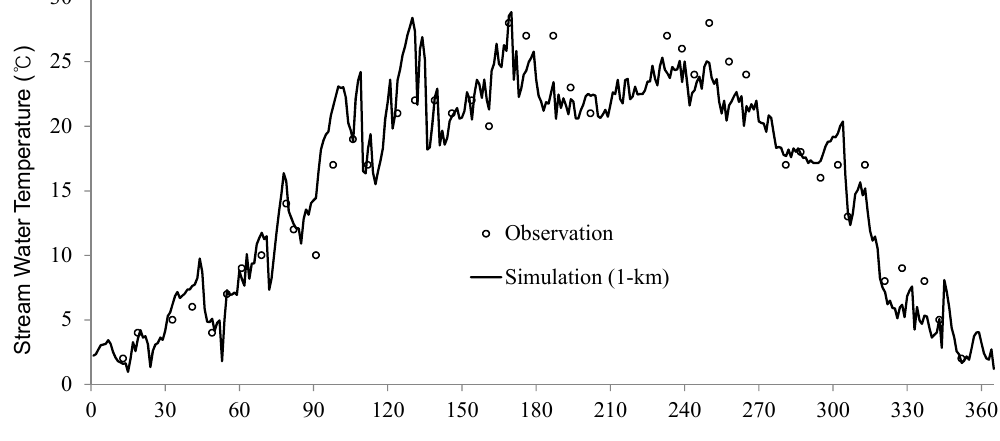
Figure 9. Comparison of daily time series of stream water temperatures estimated from the regression analysis with the 1-km CoLM land surface temperature simulation results along with 42 stream water temperature observations at the KMA stream gauge station Y-A in